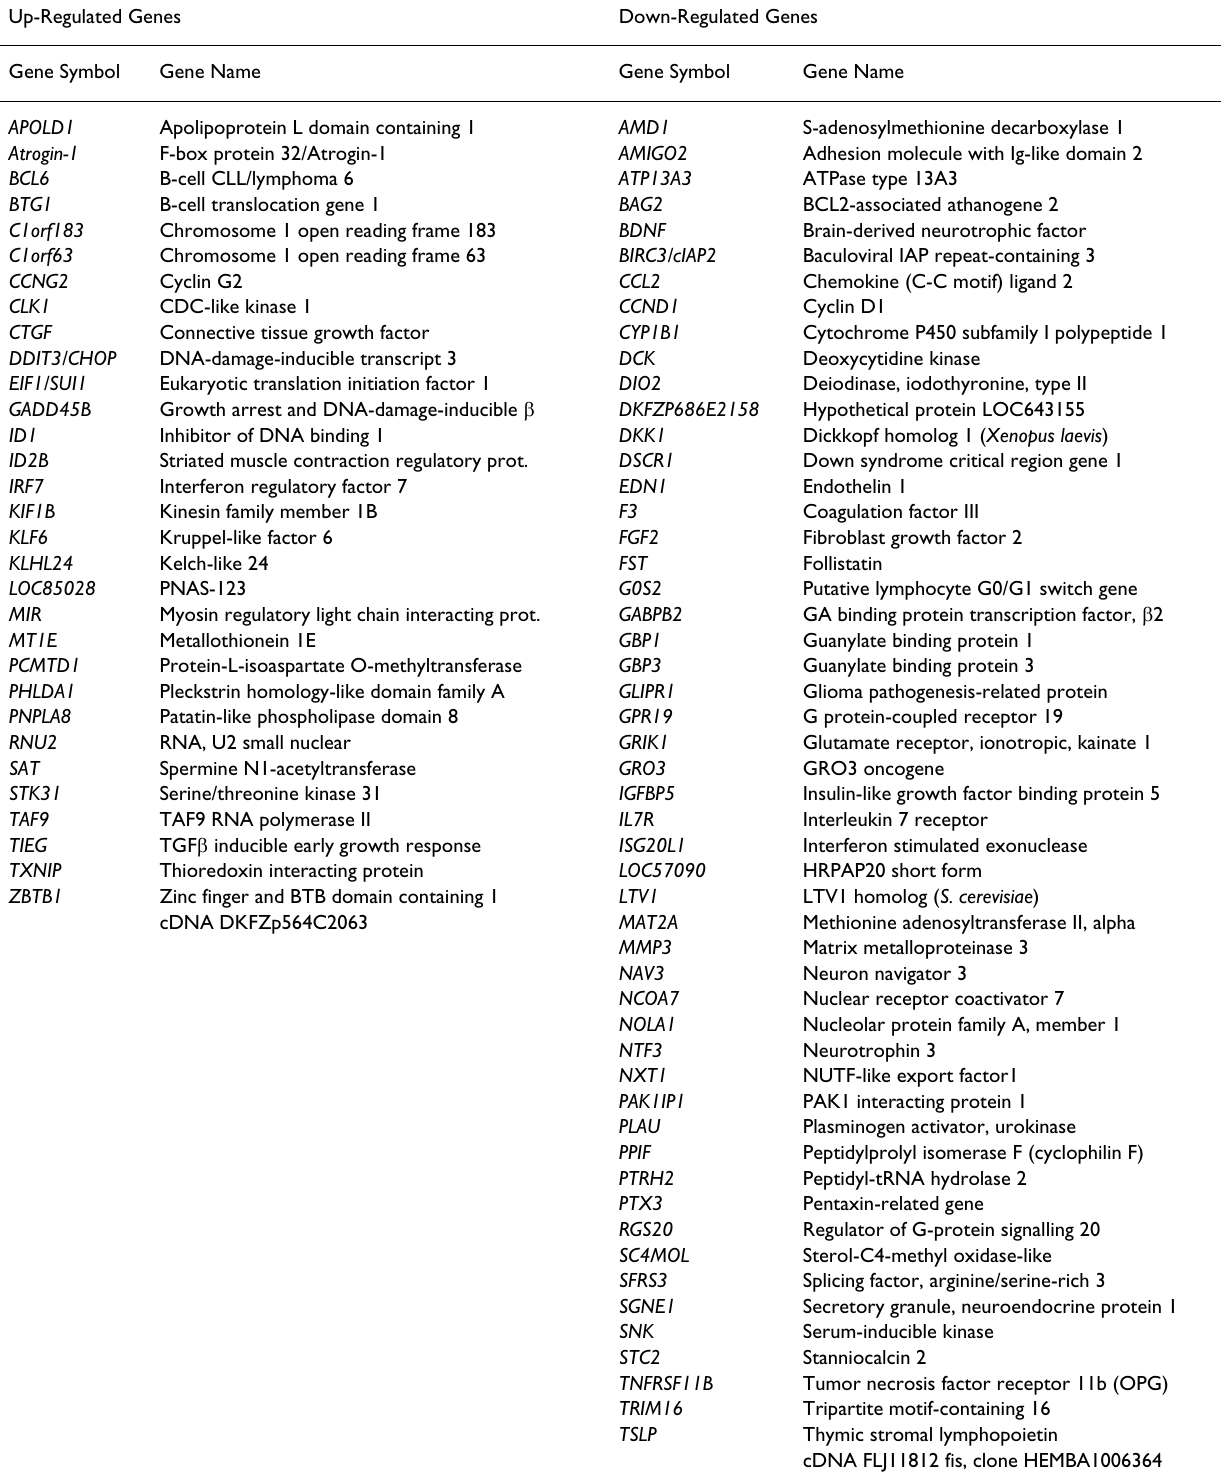
Table 1: Gene expression changes after 2 and 4 hours of PI 3-kinase inhibition Up-Regulated